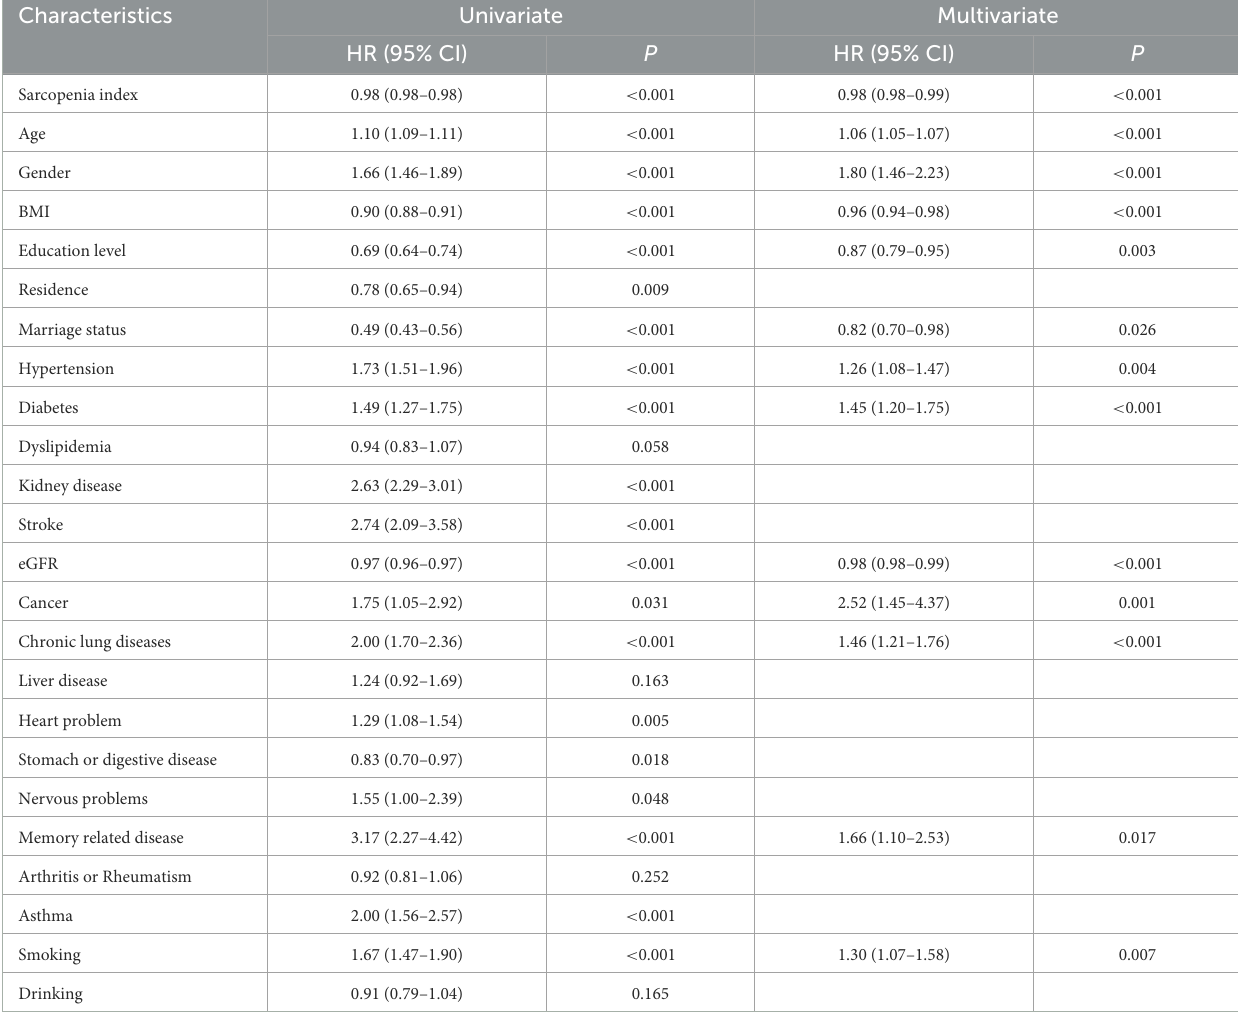
TABLE 2 Univariate and multivariate analysis the relationship between SI and all-cause mortality. Characteristics